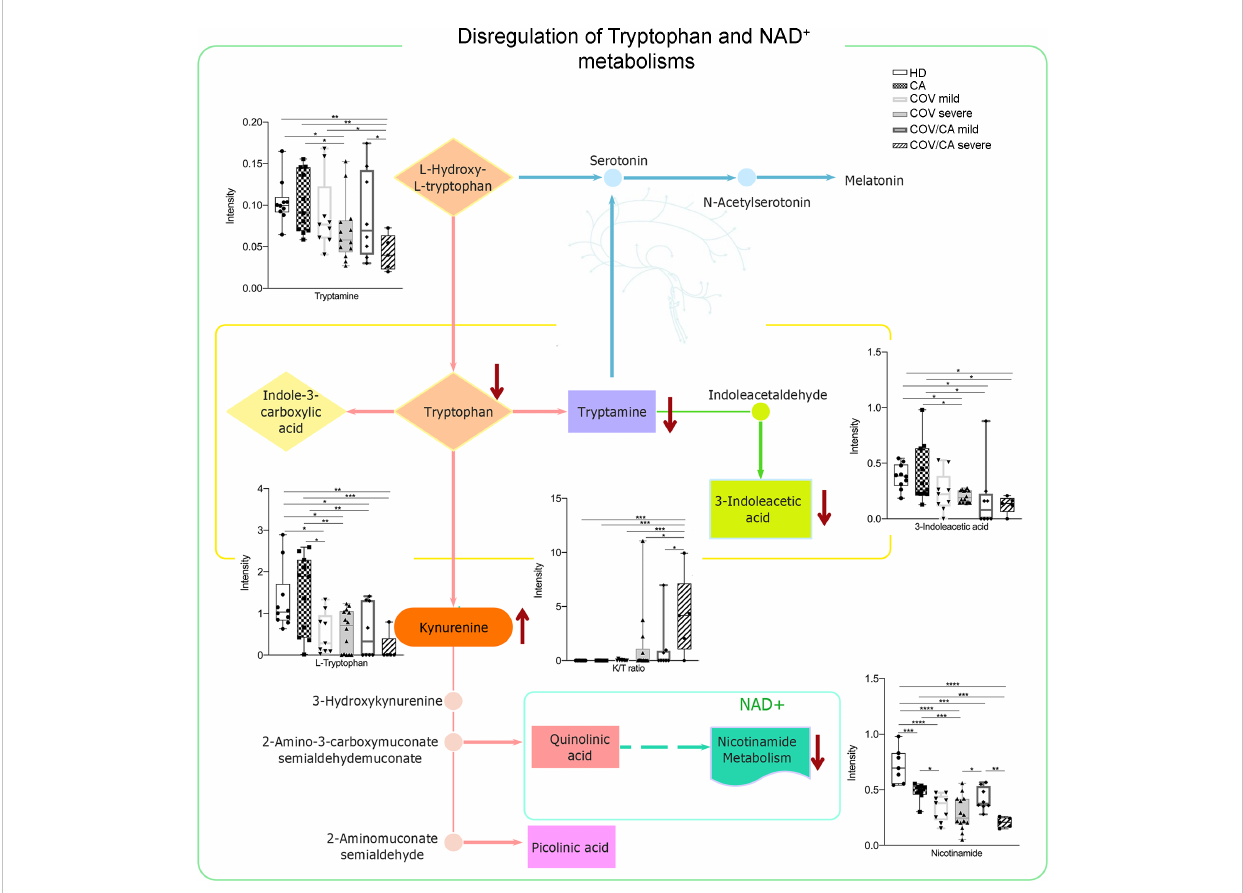
FIGURE 8 Biochemical map of plasma dysregulations of Tryptophan and NAD + metabolism. Boxplots of the main altered molecules: tryptamine, L-tryptophan, 3-indoleacetic acid, nicotinamide and K/T (kynurenine/L-tryptophan) ratio. Healthy subjects (green), cancer patients (purple), cancer patients with (orange) or without (blue) COVID-19; * P < 0.05, ** P < 0.01, *** P < 0.001, **** P <